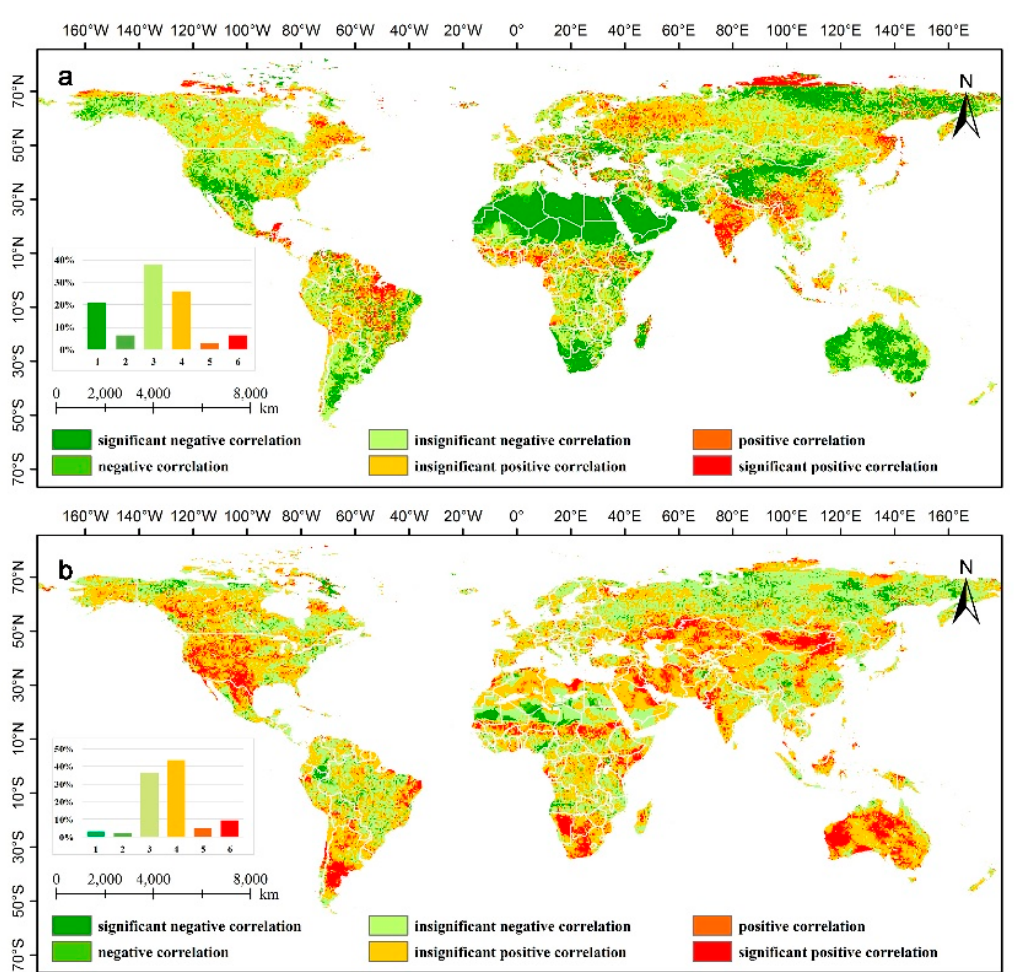
Figure 5. Global maps of correlation coefficients between annual averages NDVI and temperature ( a ) and rainfall ( b ) form 1982–2015.